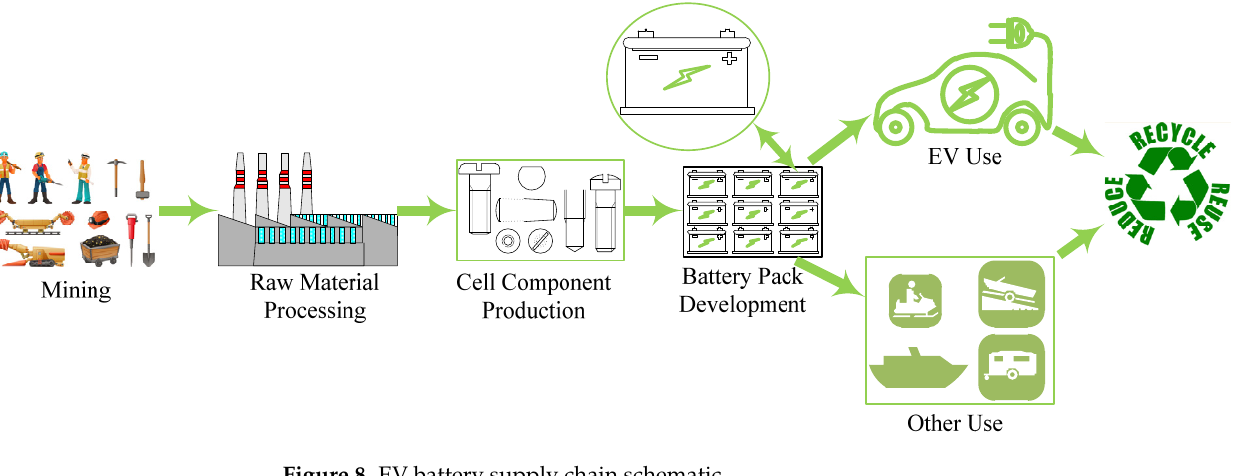
Figure 8. EV battery supply chain schematic.